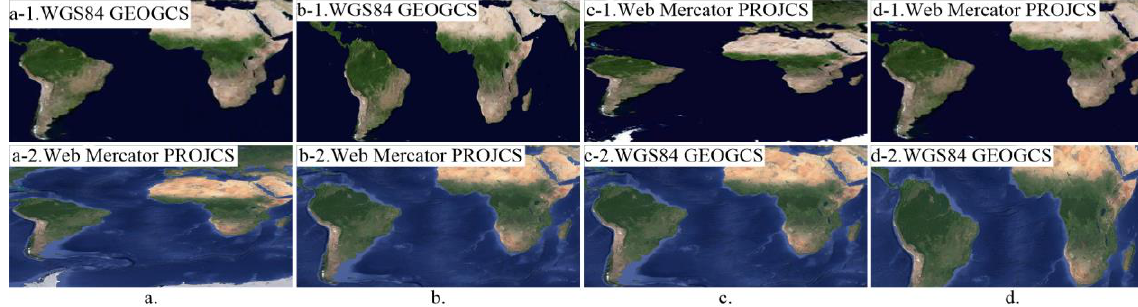
Figure 6. Diagram under the different data sources with different space references (with